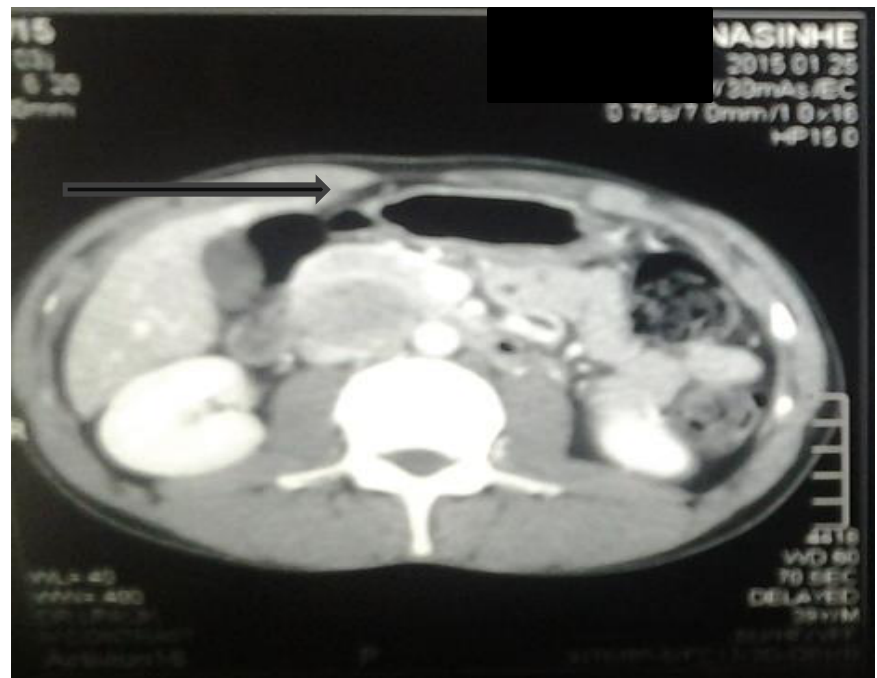
Figure 1: CT image showing an abdominal